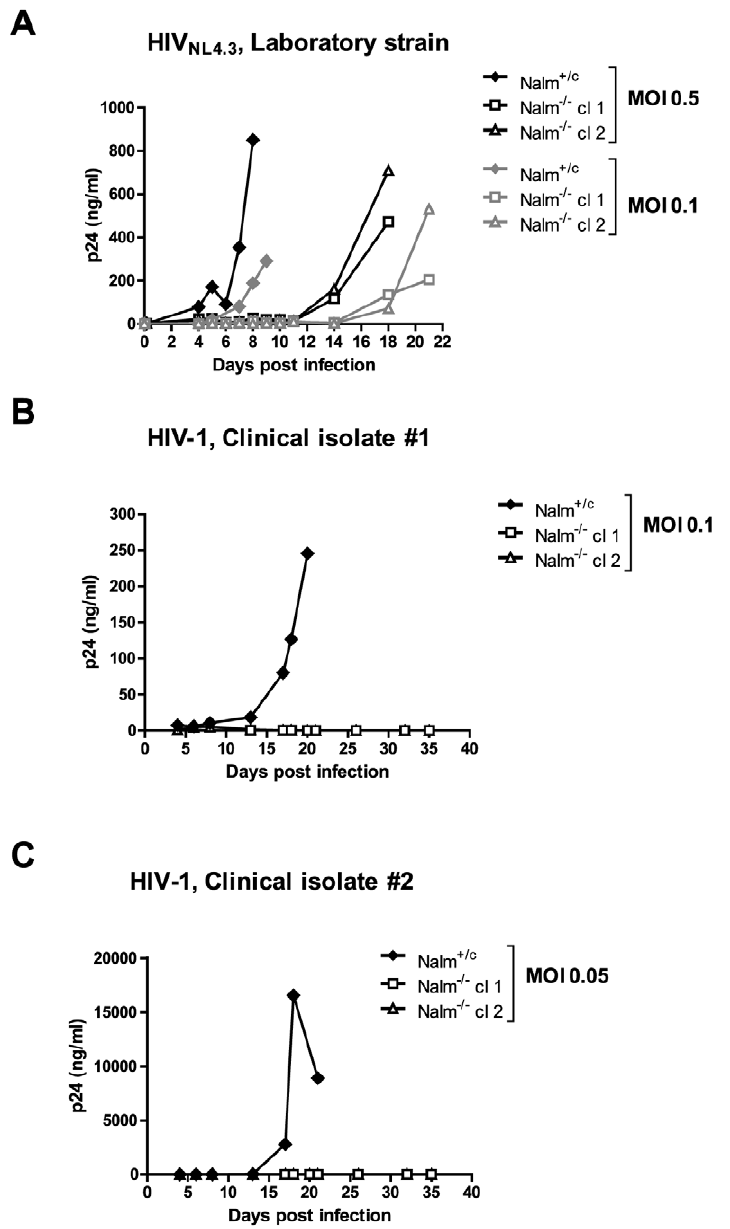
Figure 2. Residual HIV-1 replication in LEDGF/p75 KO cells is only observed after challenge with laboratory strains. Control Nalm + /c and KO Nalm 2 / 2 cl 1 and cl 2 cell lines were challenged with the laboratory strain HIV NL4.3 (A) and clinical isolates # 1, 93TH053 (B) and # 2, 96USSN20 [32] (C). Cells were infected at different MOI as indicated. Replication was monitored by measuring the p24 content of the supernatant. Experiments were repeated at least three times; representative experiments are